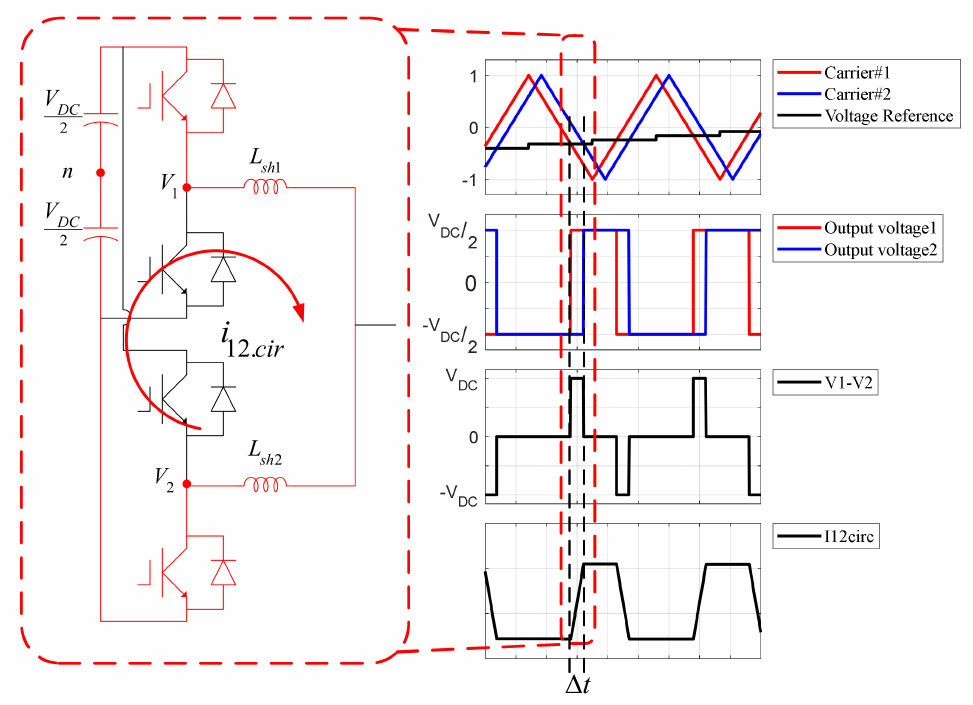
Figure 2. The mechanism of circulating current generation using two single − phase half − bridge